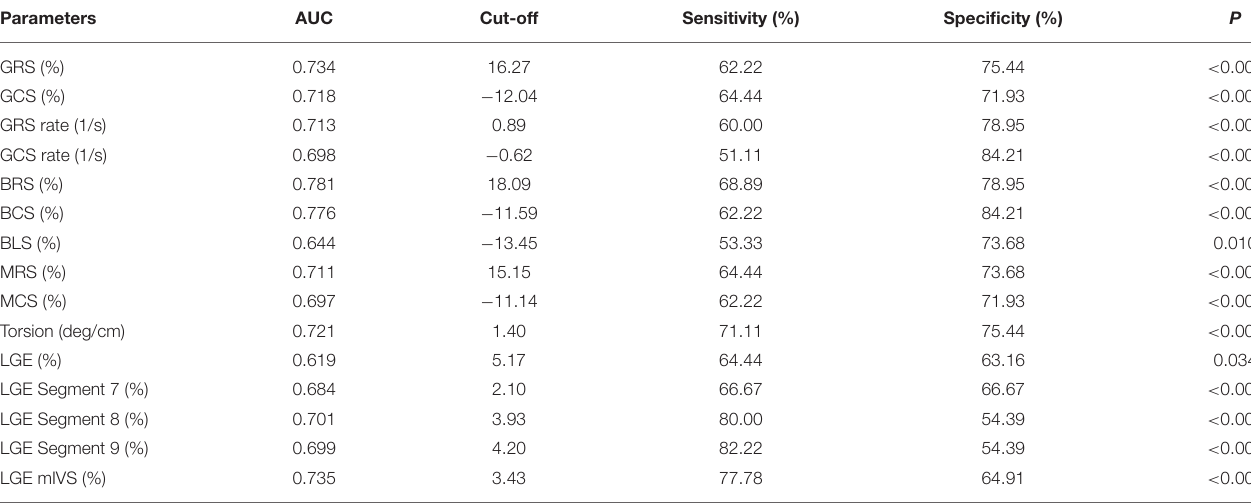
TABLE 4 | Results of the ROC for discrimination of patients with HCM and HHD. Parameters